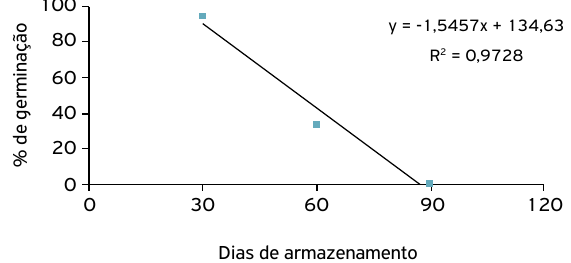
Figura 5. Porcentagem de germinação de conídios de B. bassiana em mistura granulada acondicionada em embalagem de polietileno armazenada em câmara climatizada (temperatura 25 ± 1°C) durante 90